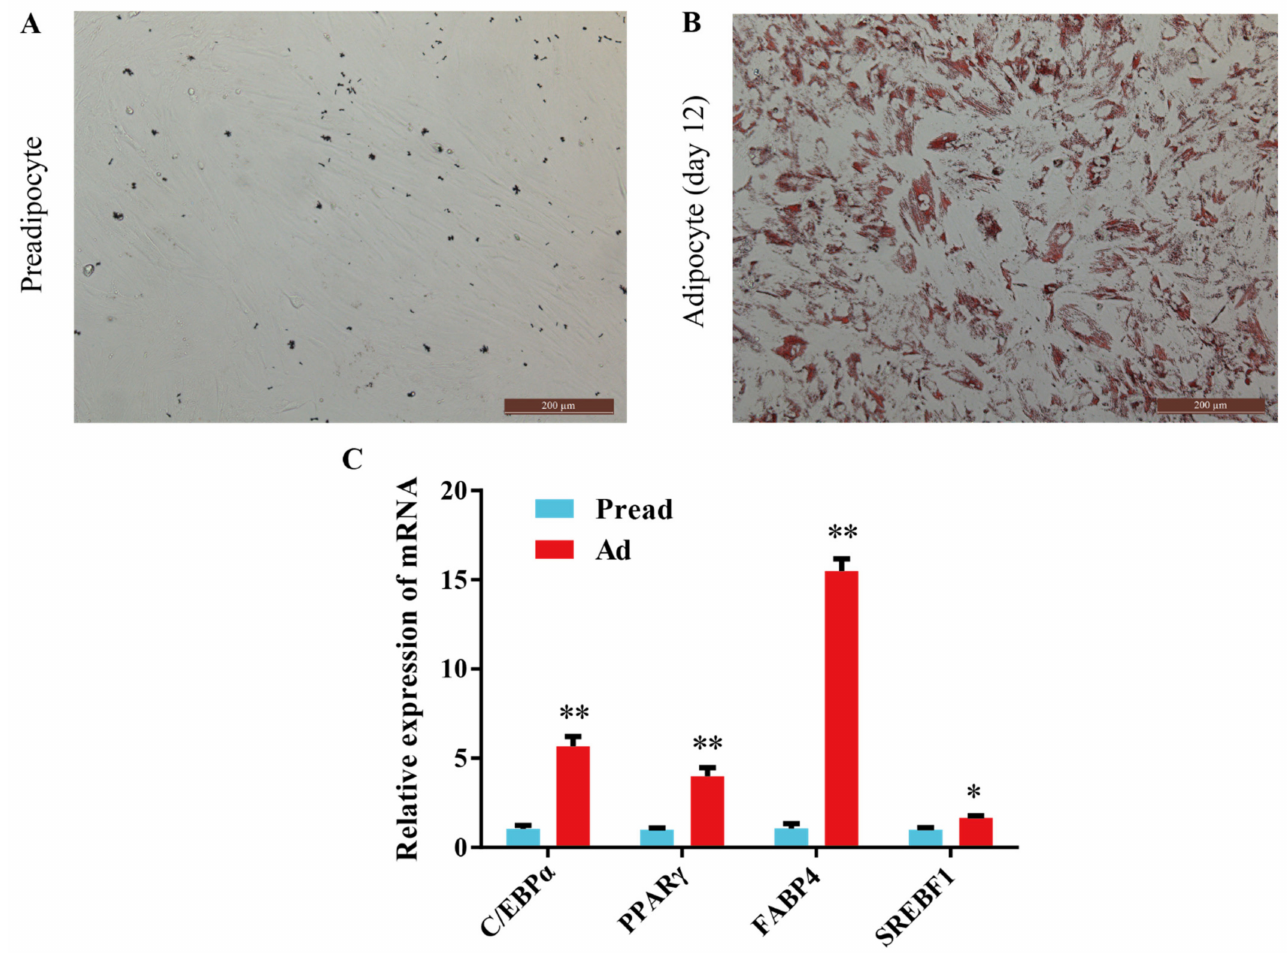
Figure 1. Induction of adipocyte differentiation. ( A , B ) Oil red O staining of preadipocytes and adipocytes. ( C ) The mRNA expression level of C/EBP α , PPAR γ , FABP4 and SREBF1 between the preadipocytes and adipocytes (mean ± SEM, n = 3, * p < 0.05, ** p <